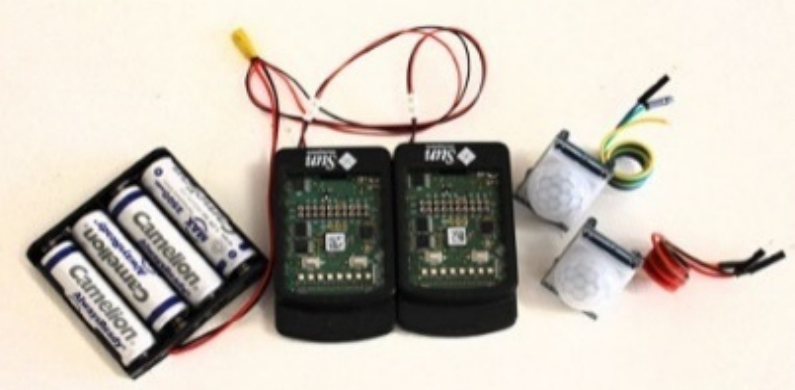
Figure 4. Observation unit includes a pair of passive infra-red (PIR) sensors, a SunSpot sensor, and a battery package.